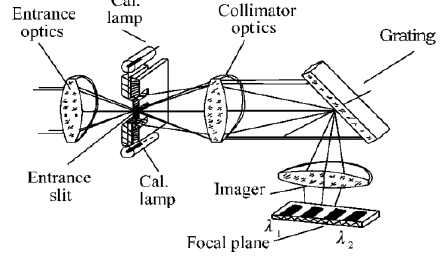
Figure 1. lamp calibrator of MOS (MMERMANN G. et al,1993a)